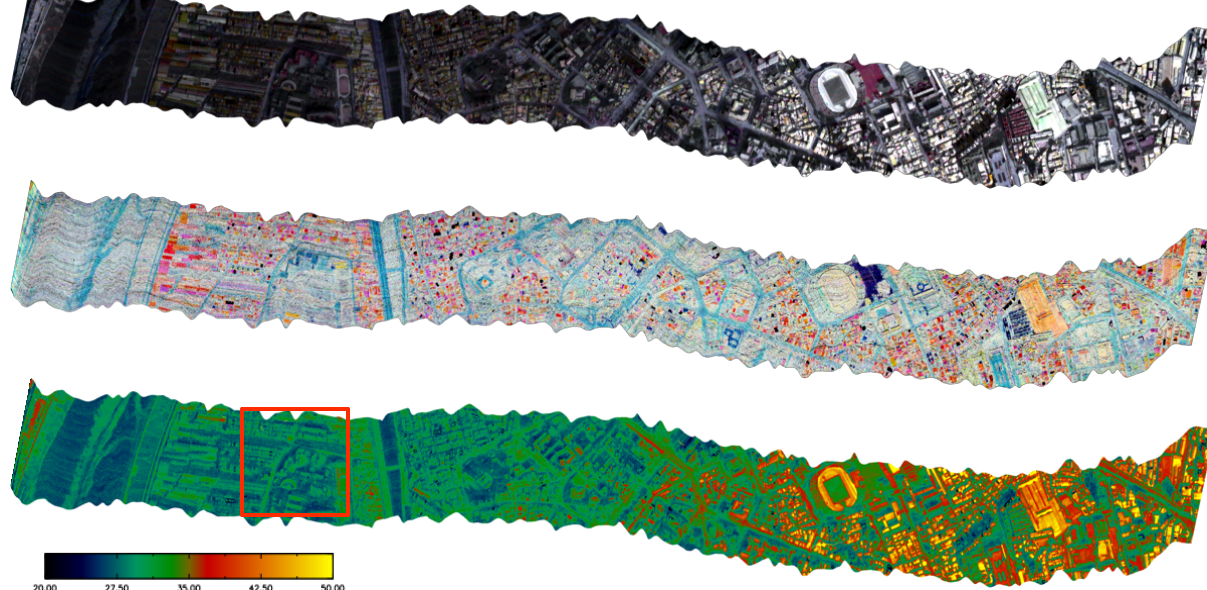
Figure 3. OWL scene of Taipei, Top: Spectral radiance (R:8.2, G:9.8, B: 11.2 µm ), middle: spectral emissivity, same wavelengths; bottom: temperature ( 20 − 50 o C ). Data courtesy of SPECIM Inc.